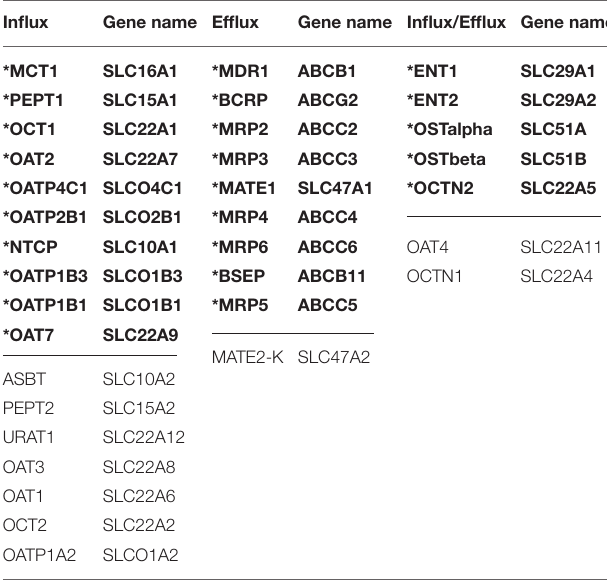
TABLE 1 | Clinically important drug